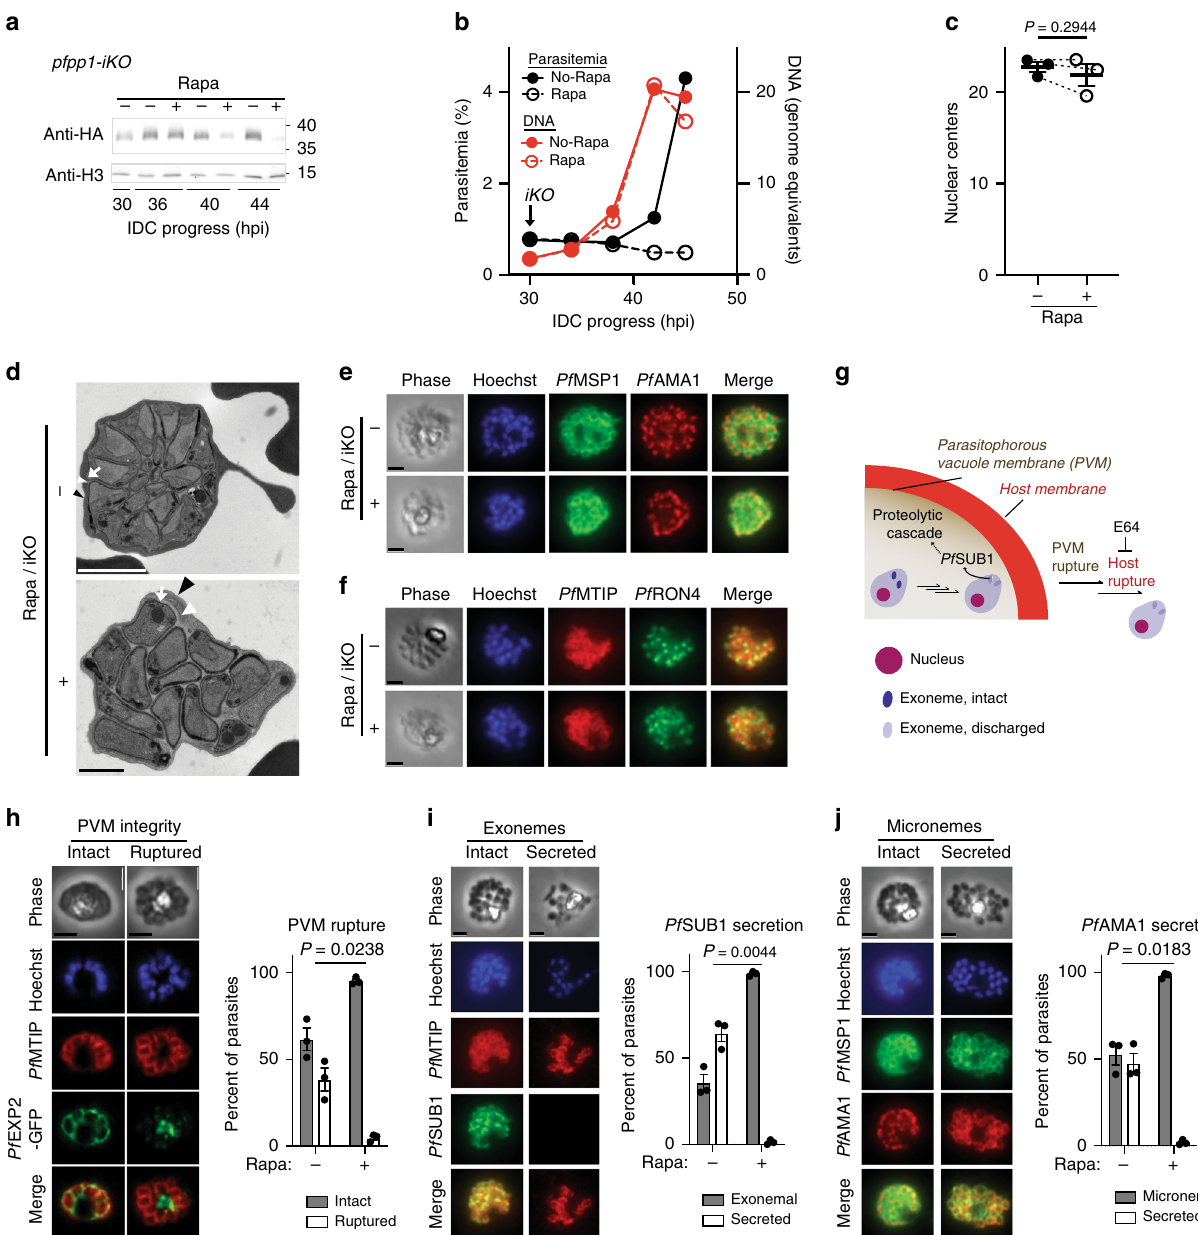
Fig. 2 P f PP1 function at an early step of parasite egress from erythrocytes. a Pf PP1-HA 3 expression + / − Rapa-mediated iKO of pfpp1 at 30 hpi, assessed by immunoblot. Representative of 2 experiments. Molecular mass in kDa. b Parasitemia and DNA synthesis following iKO of pfpp1 at 30 hpi, as in Fig. 1c. Mean of 3 technical replicates. Representative of 4 experiments. c Nuclear centers in terminally developed parasites following Rapa-mediated iKO of pfpp1 at 30 hpi, as in Fig. 1. Mean± s.e.m.; n = 3 experiments; two-tailed t test. d Electron microscopy of terminally developed pfpp1 - iKO parasites treated + / − Rapa at 30-hpi. In both images, the different membranes are indicated as follows: erythrocyte (black arrowhead), PV (white arrowhead), and parasite (white arrow). Representative of 2 experiments. Scale bars: 2 µ m (top), 1 µ m (bottom). e , f Immuno fl uorescence analysis of the microneme antigen Pf AMA1 e or the rhoptry-neck antigen Pf RON4 f in terminally developed parasites + / − iKO of pfpp1 at 30 hpi. The images also show the parasite plasma membrane marker Pf MSP1 e and the inner membrane complex marker Pf MTIP f . Scale bar: 2 µ m. For both panels, representative of 2 experiments. g In a mature parasite, regulated secretion of Pf SUB1 from exonemes stimulates a proteolytic cascade leading to sequential rupture of the PVM and the erythrocyte host membranes. h PVM rupture at 45 hpi in pfpp1-iKO / Pf EXP2-GFP parasites treated + / − Rapa at 30 hpi. Left: immuno fl uorescence images of parasites with intact or ruptured PVMs. Right: Proportion of infected cells exhibiting PVM rupture. For h – j , mean ± s.e.m.; n = 3 experiments; two-tailed t test. In h – j , parasites were treated with E64 (50 µ M) at 41 hpi; the completion of cytokinesis was assessed with the inner membrane complex marker Pf MTIP or the parasite plasma membrane marker Pf MSP1. Scale bars ( h – j ): 2 µ m. i With + / − Rapa-treatment at 30 hpi in pfpp1-iKO parasites, quanti fi cation of Pf SUB1 secretion from exonemal compartments (loss of punctate fl uorescence in images at left), as in h . j Assessment of Pf AMA1 secretion from micronemes, as in h and i . Source data are provided as a Source Data fi